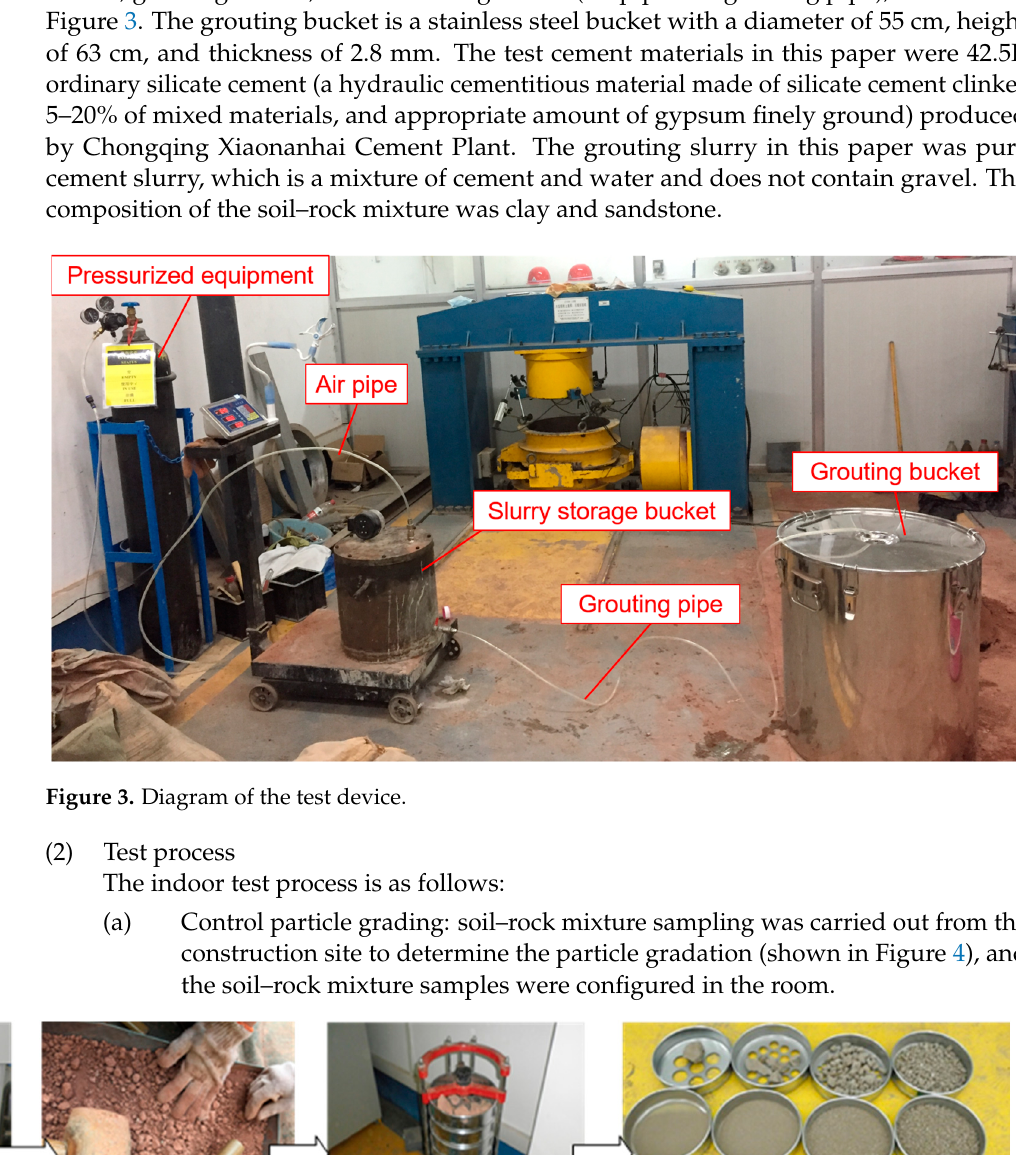
8 of 22 Table 1. Orthogonal test table of the grouting test. Groups